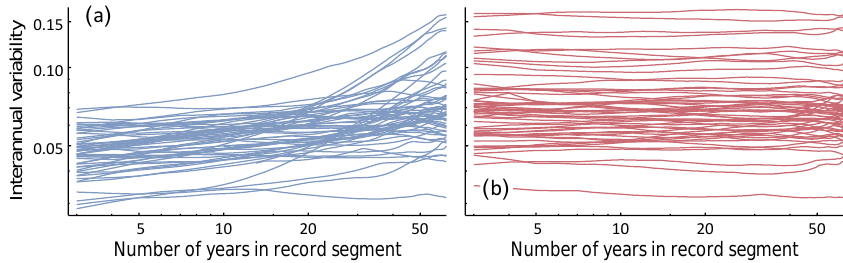
Figure 4. Average interannual variability (cid:104) CV j (cid:105) of wind speed vs. time-segment length j for each of 60 stations: (a) actual data, (b) randomly permuted